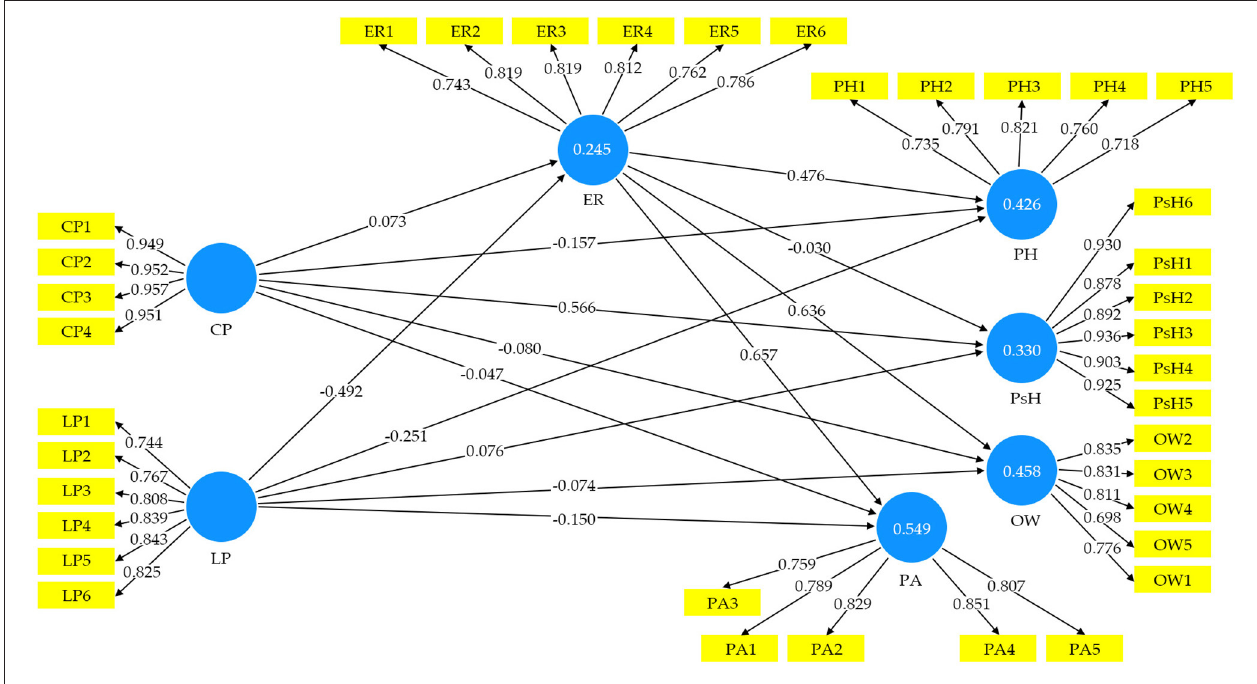
FIGURE 1 | Conceptual model.